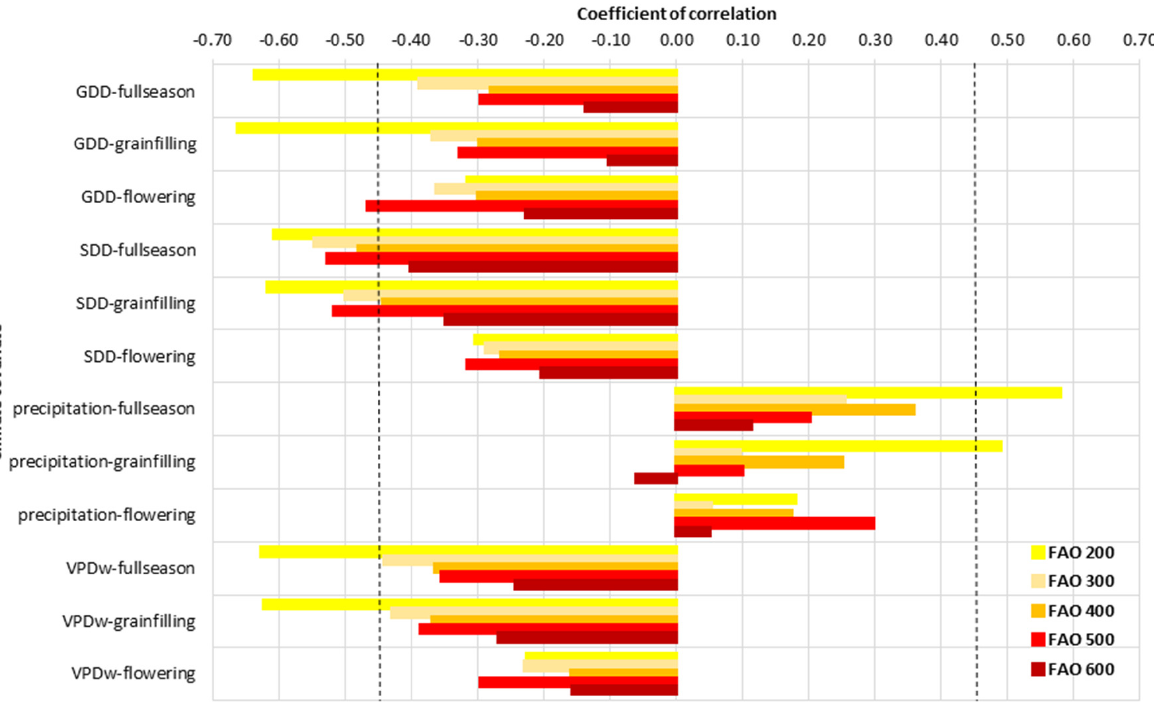
Figure 2. Correlation coefficients between 12 climate covariates and maize grain yield for five maturity groups (FAO 200–FAO 600) in the experiment during the period of 1996 to 2015. The dashed vertical lines denote significance level at p < 0.05. Table 1. Coefficients of regression of maize grain yield (t/ha) on SDD full-season values. SE, t, and p are the standard error, the t statistic, and p value of the fitted parameter.